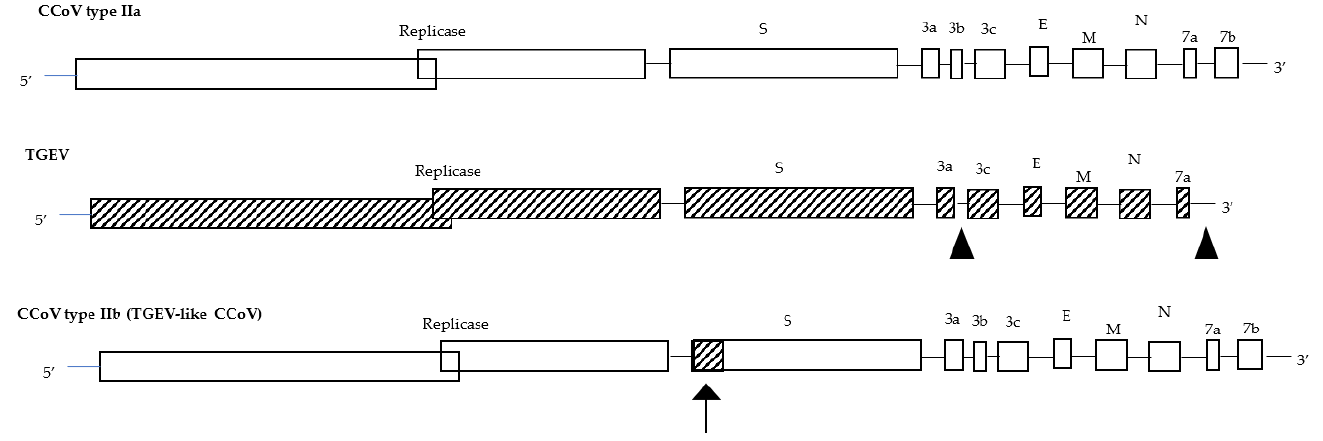
Figure 1. Genome organization of CCoV type IIa, TGEV, and CCoV type IIb (TGEV-like CCoV). The arrow shows the recombination site.